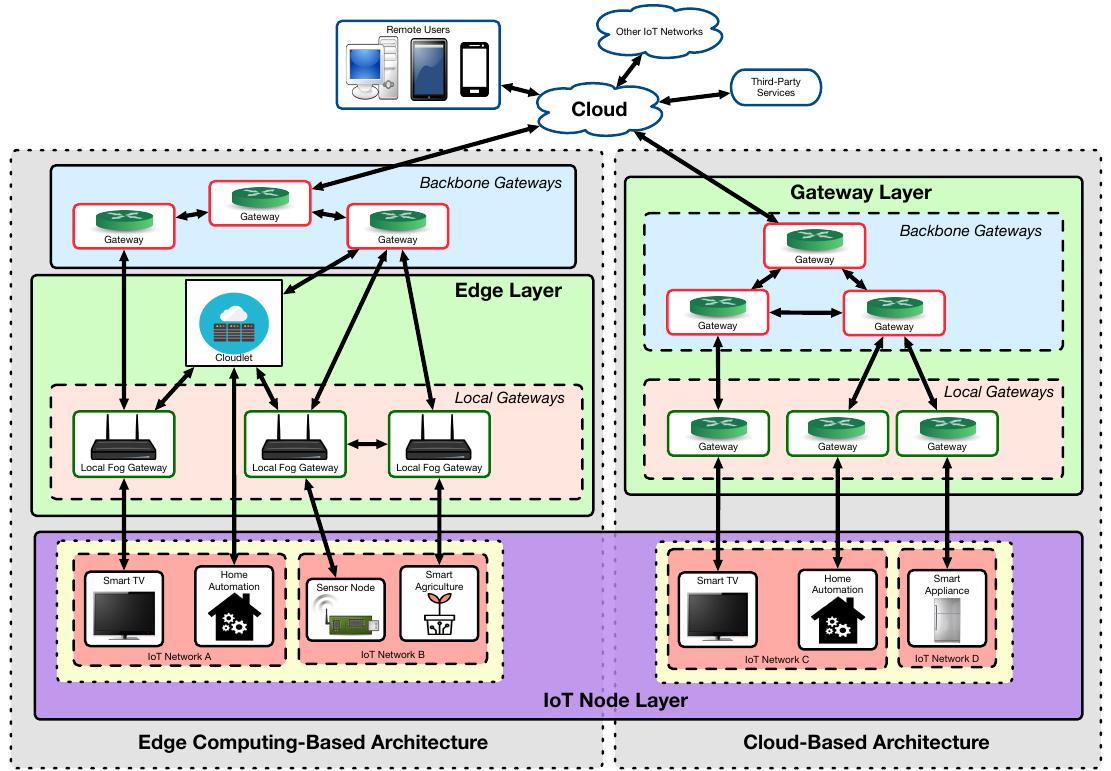
Figure 2. Components of cloud-based and edge computing-based IoT